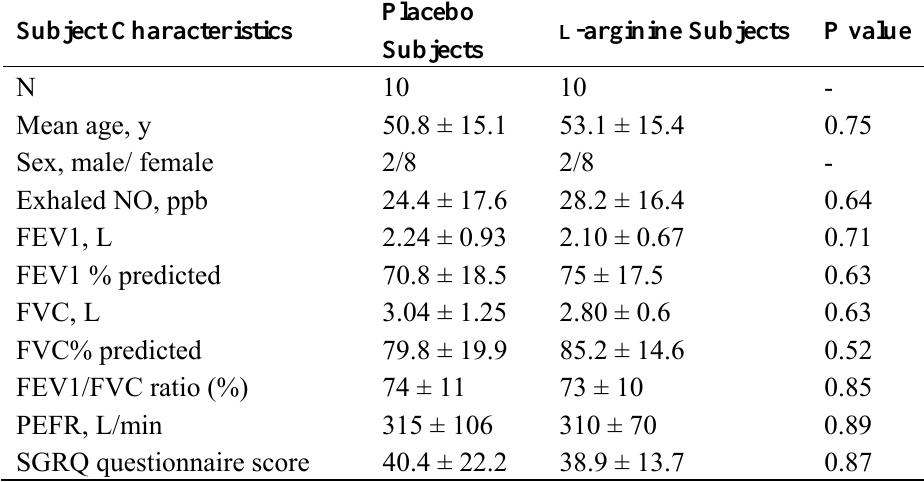
Table 1. Baseline study participants (values are expressed as mean ± SD).